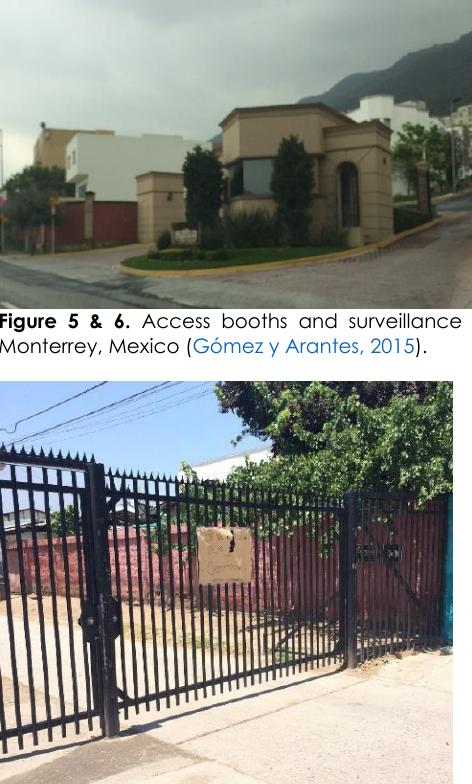
Figure 7. Self-segregation manifestation in Santiago, Chile (Gómez, 2015).